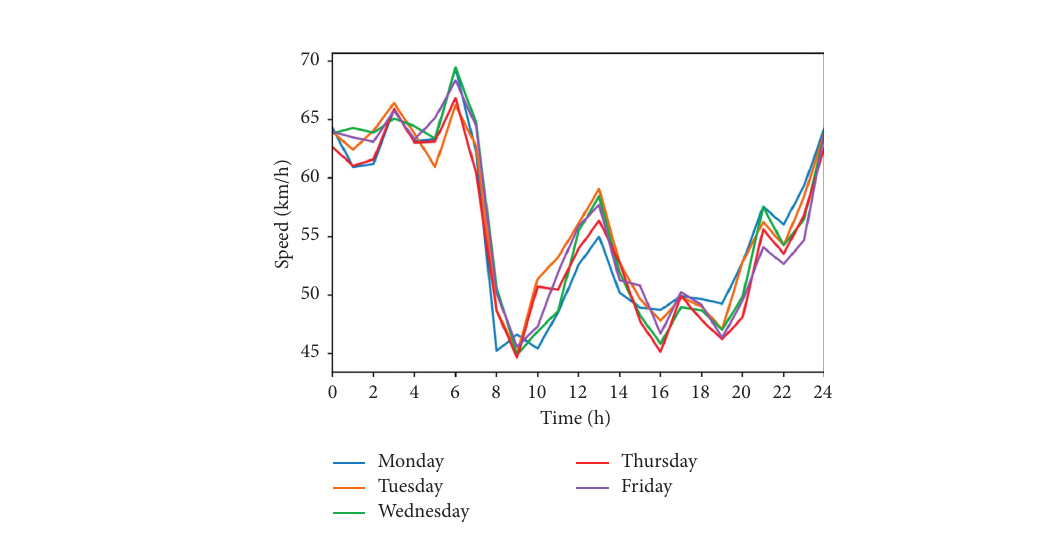
Figure 4: Signal after wavelet transform.